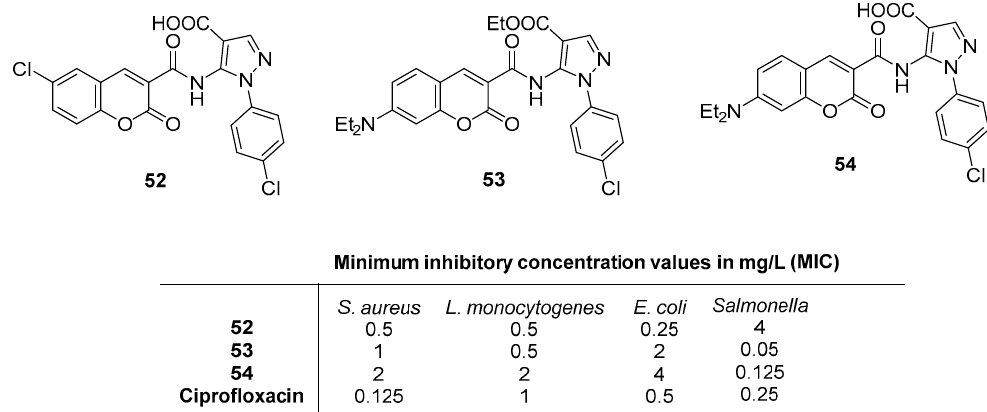
Figure 21. Selected coumarin-pyrazole carboxamide derivatives developed by Liu et al. and their MIC values [87].